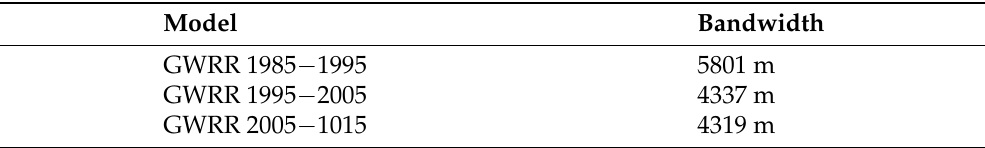
Table 3. Model Parameters